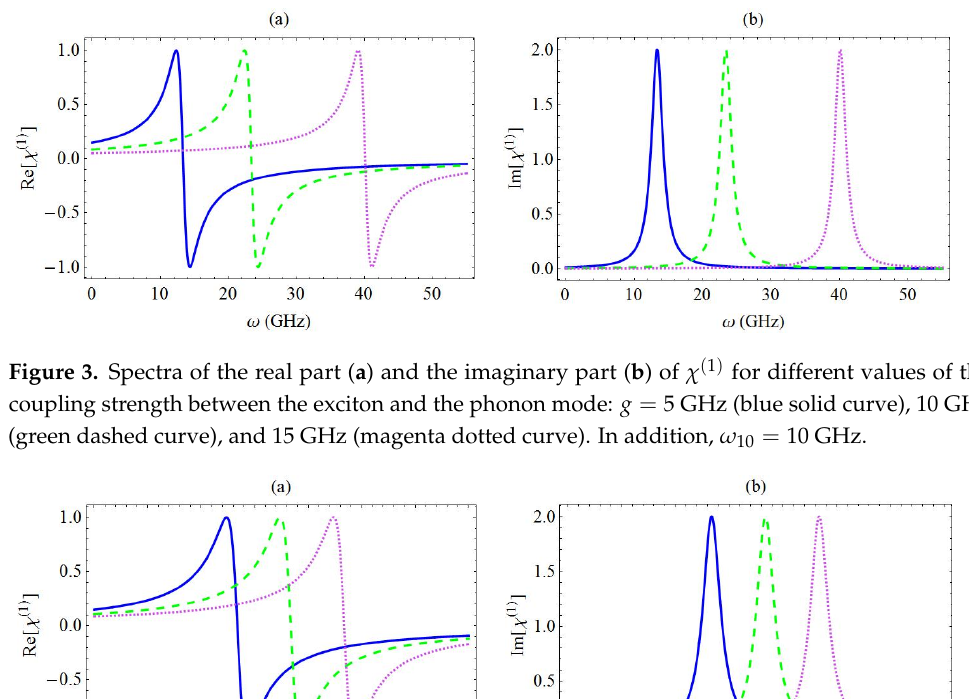
Figure 4. Spectra of the real part ( a ) and the imaginary part ( b ) of χ ( 1 ) for different values of the exciton energy: ω 10 = 5 GHz (blue solid curve), 10 GHz (green dashed curve), and 15 GHz (magenta dotted curve). In addition, g = 10 GHz.